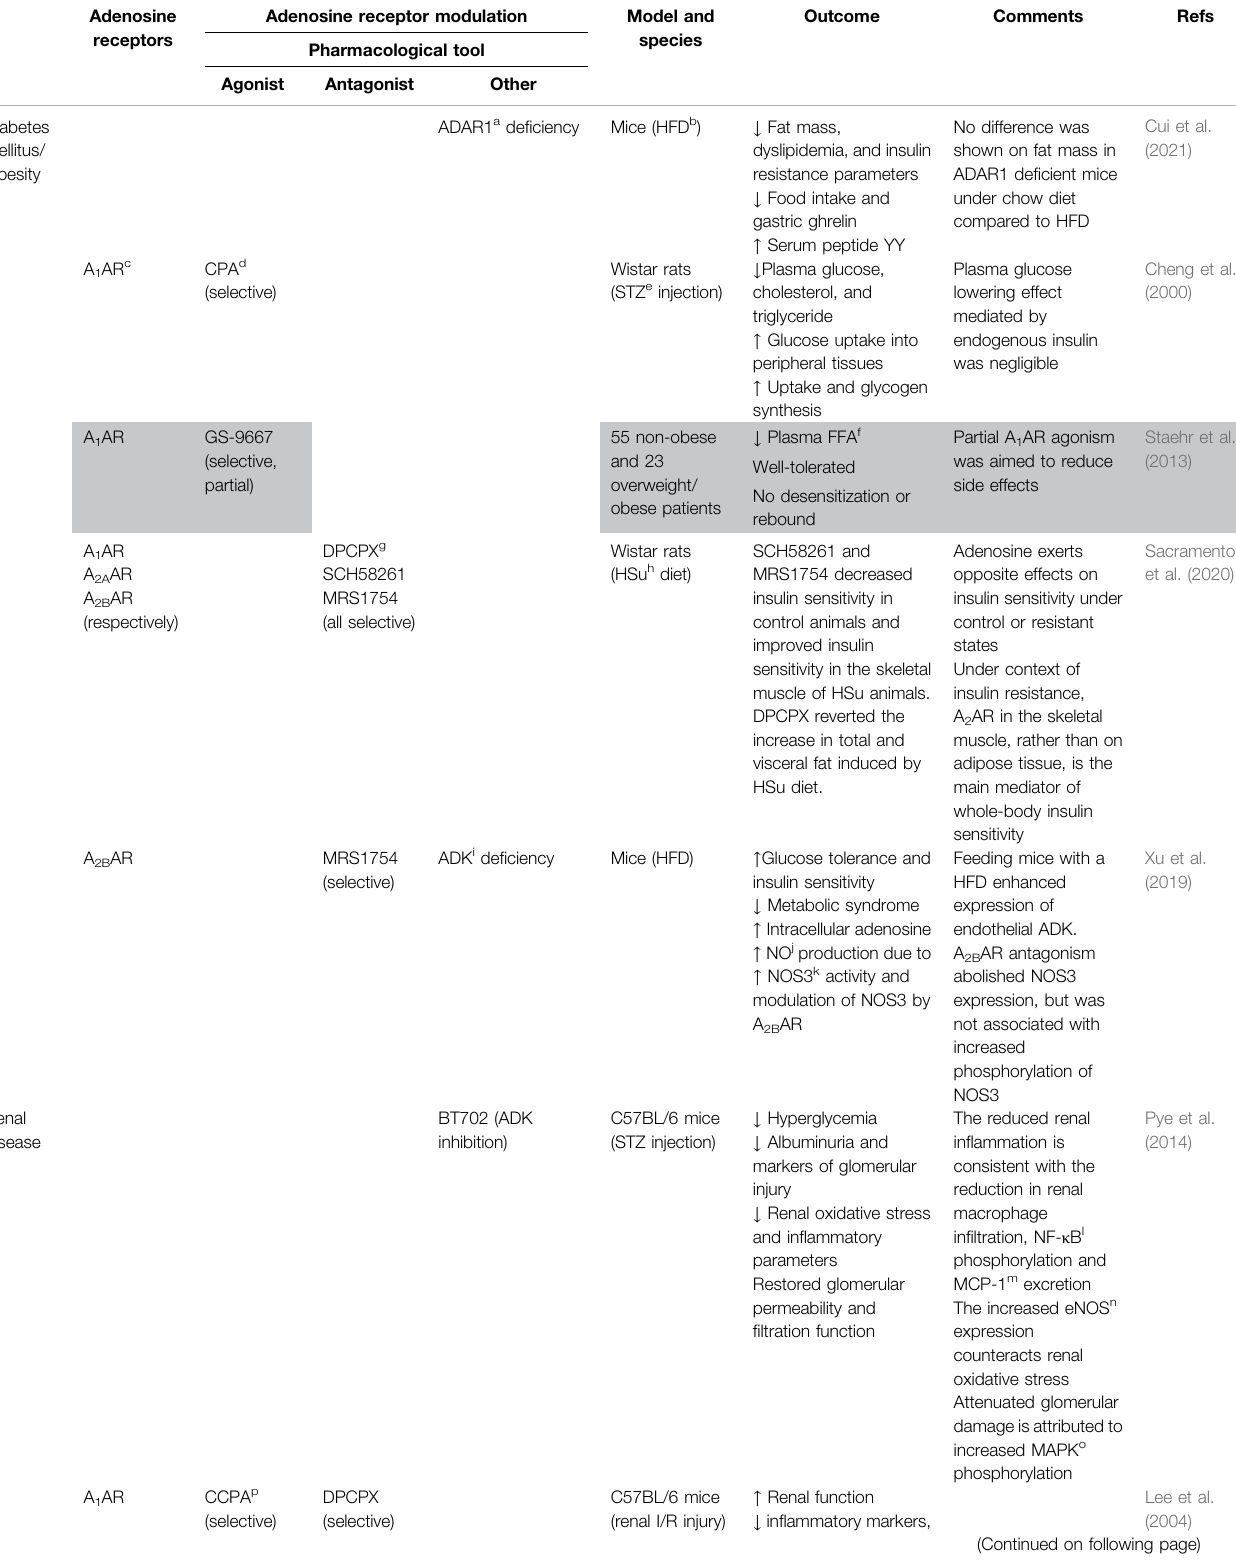
TABLE2| Resultsofadenosinereceptorsagonism/antagonismindiabetesmellitus/obesityandchronickidneydisease.Differentagonists/antagonistswereusedtoassess its effects on HFpEF comorbidities. The grey area corresponds to studies carried out in human